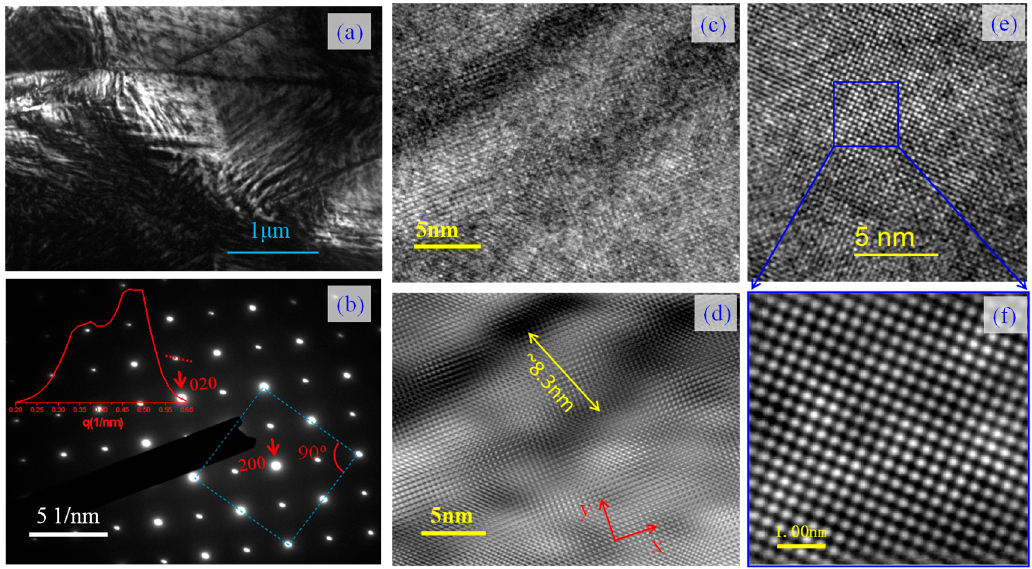
Figure 5. TEM images: ( a ) low TEM image; ( b ) SAED image; ( c , e ) high resolution TEM image; ( d ) corresponding to the inverse FFT image of ( c ); ( f ) corresponding to the inverse FFT image of the blue rectangle area in ( e ).